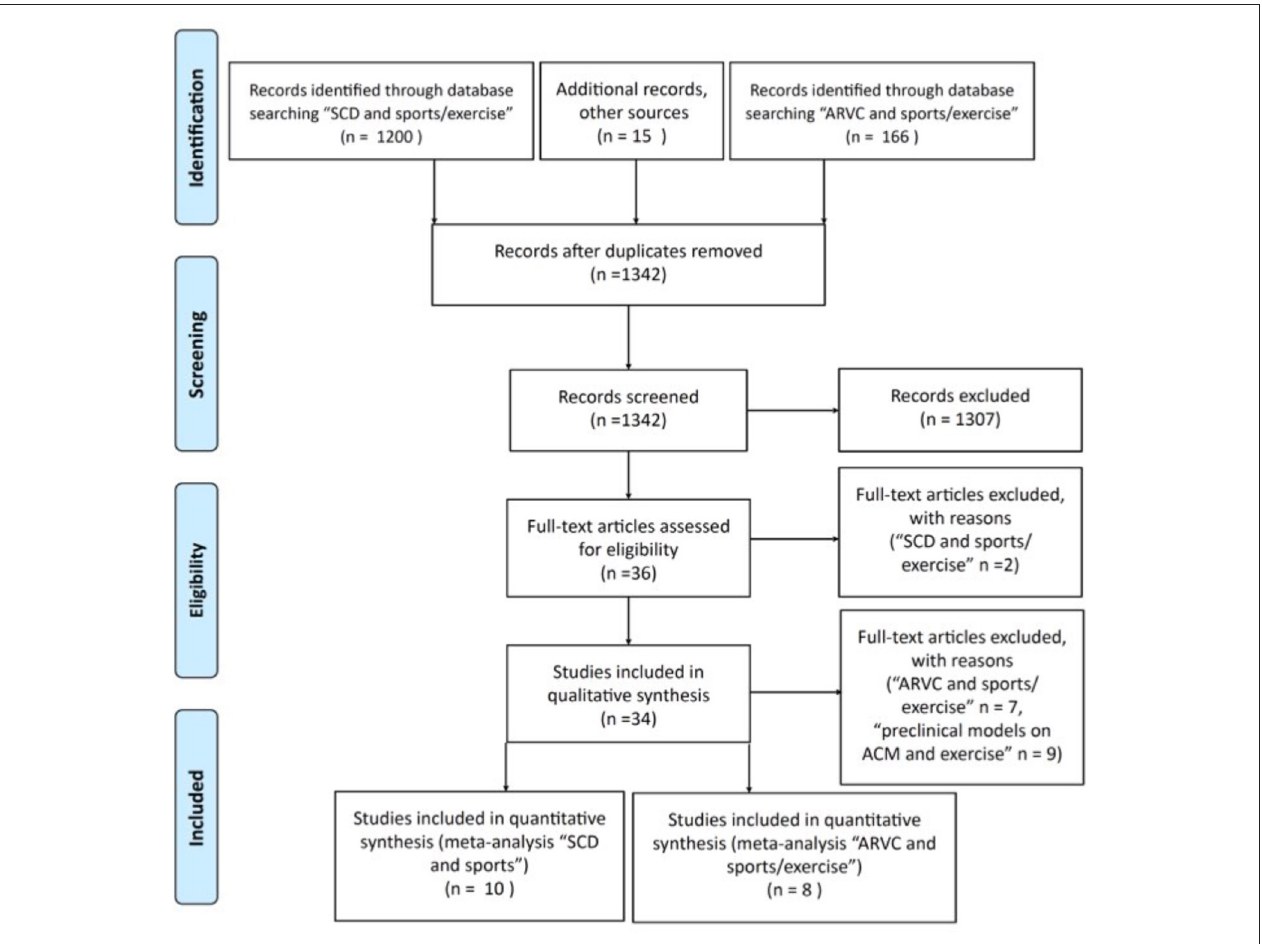
FIGURE 2 | PRISMA flowchart for the identification of papers to obtained pooled data on the causes of sports-related sudden cardiac deaths and on the estimates of life-threatening arrhythmic events in ACM patients engaged in sports. SCD, sudden cardiac death; ARVC, arrhythmogenic